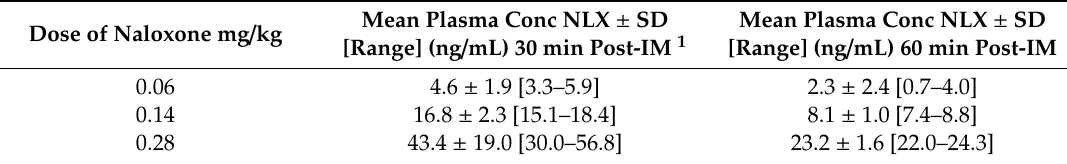
Table 4. Mean plasma concentration of naloxone at 30 and 60 min post-injection. 1